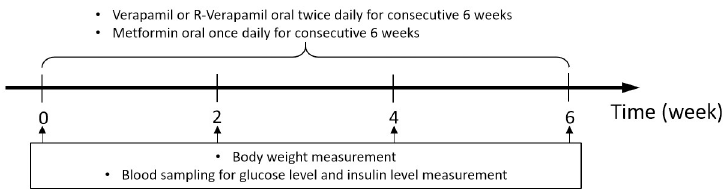
Fig 2. Scheme of db / db mice administered verapamil or R-Vera with or without metformin for 6 wks.